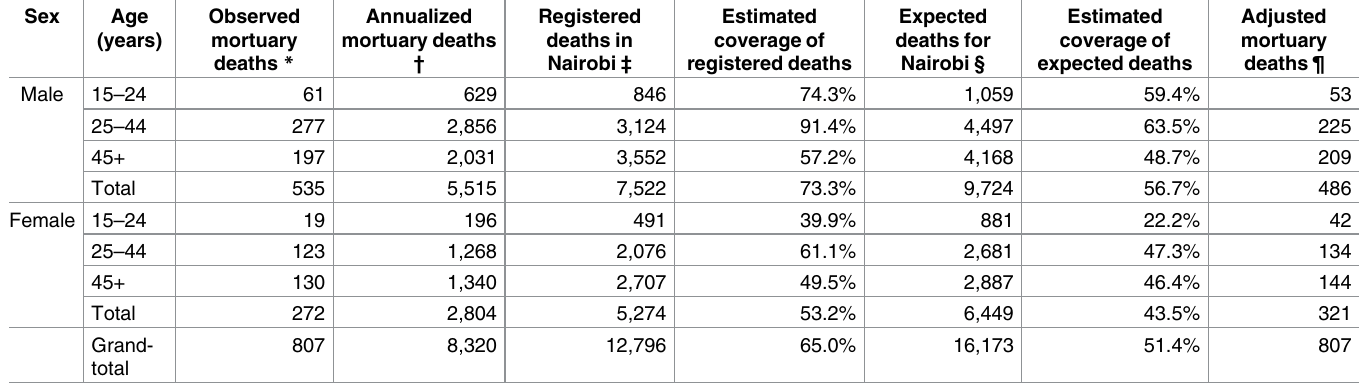
Table 2. Annualized and coverage-adjusted surveillance deaths, Nairobi 2015.